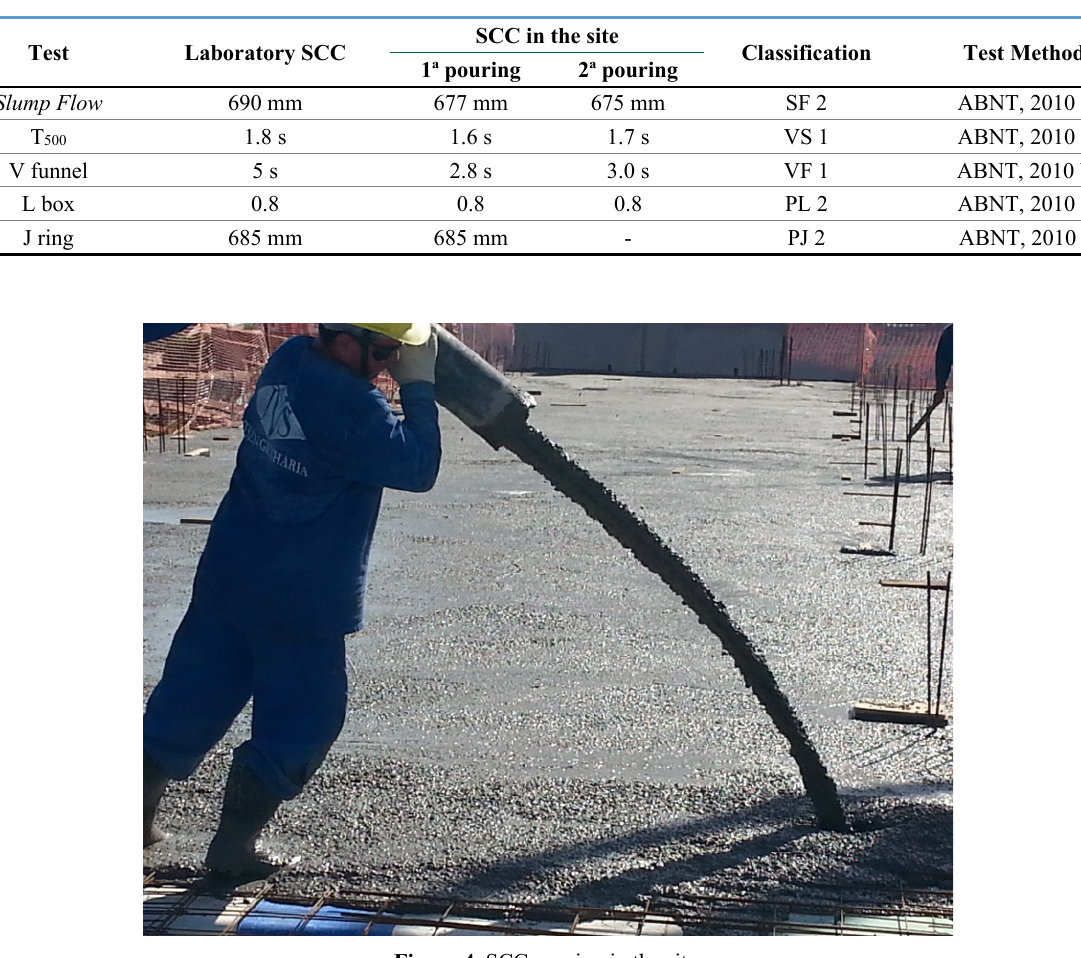
Table 6. Result of SCC tests in the fresh state.